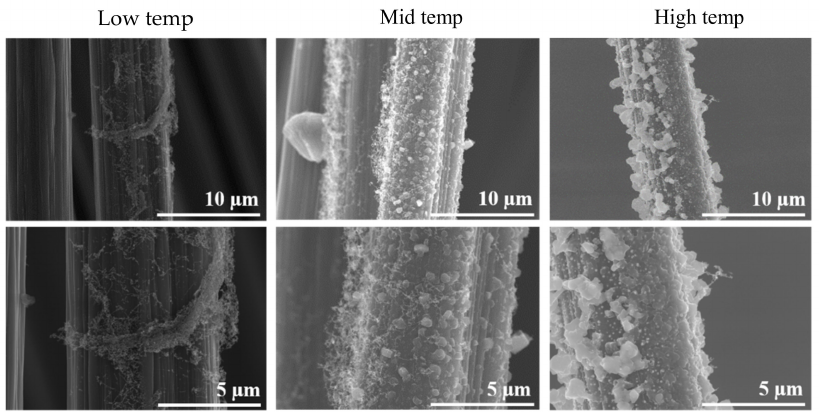
Figure 7. SWCNTs nodule and cluster formation on desized carbon fibres. The carbon clusters were confirmed by EDX, typical results are given in Figure 8 and Table 1.